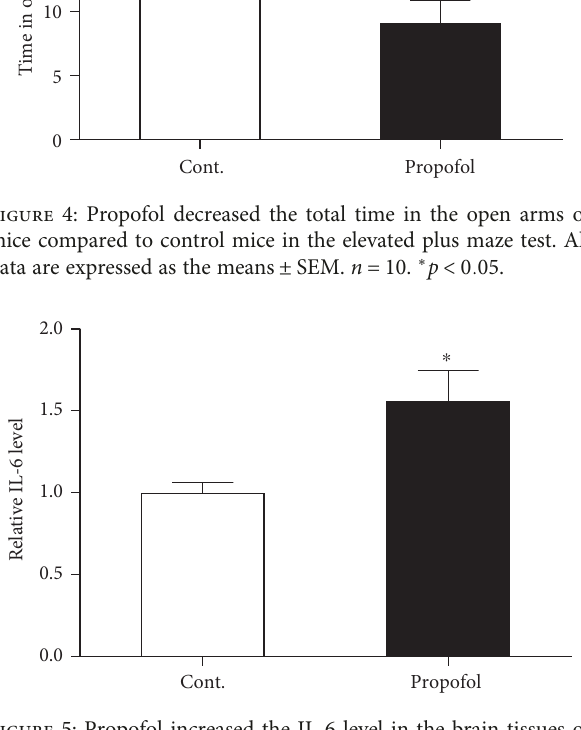
Figure 5: Propofol increased the IL-6 level in the brain tissues of mice compared to control mice. All data are expressed as the ∗ p means ± SEM . n = 6 . < 0 05